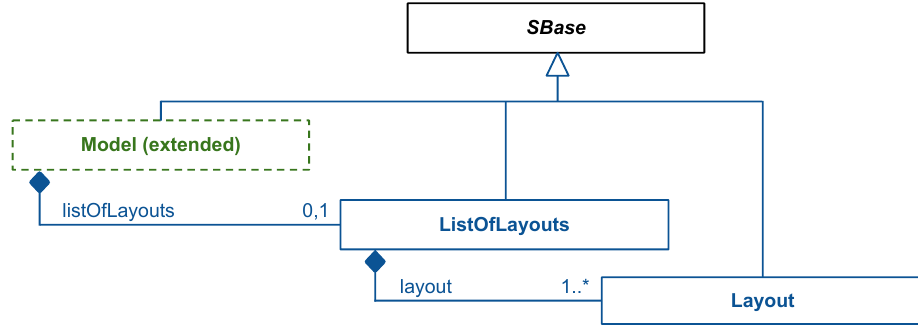
Figure 7: The definitions of the extended Model